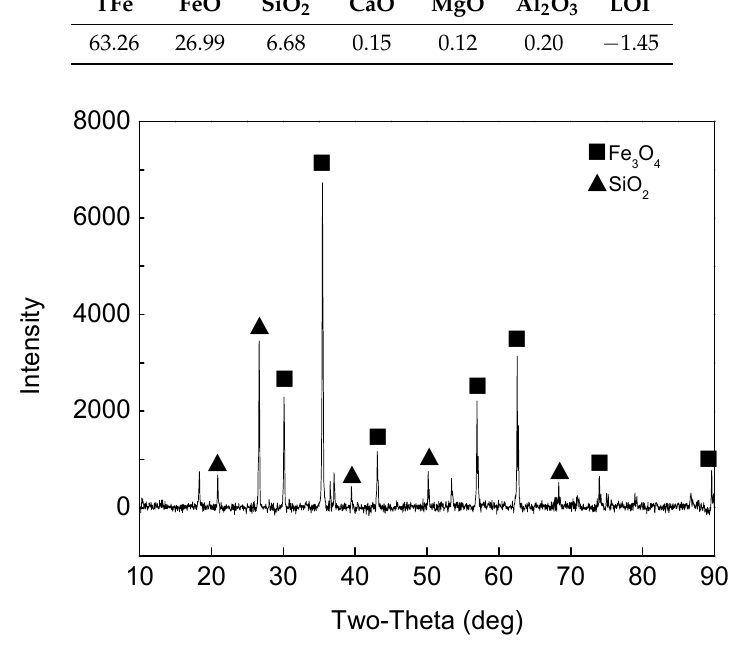
Figure 3. X-ray diffraction pattern of iron ore concentrate.